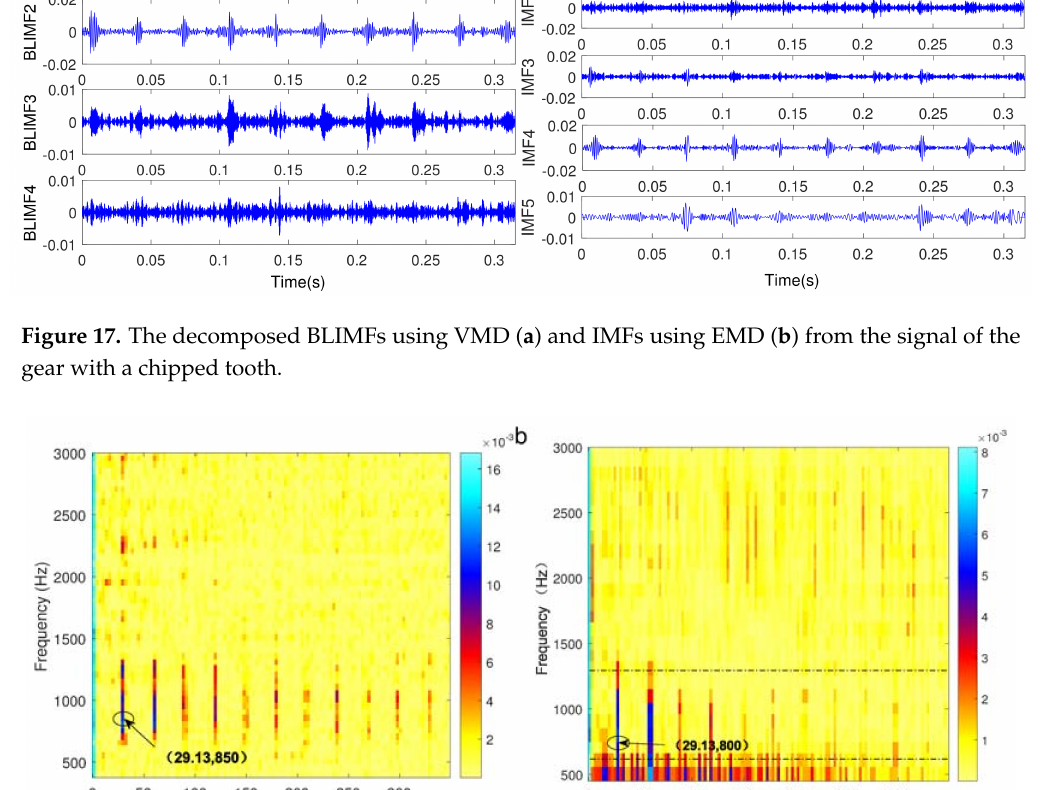
of BLIMF2 ( a ) and IMF4 ( b f